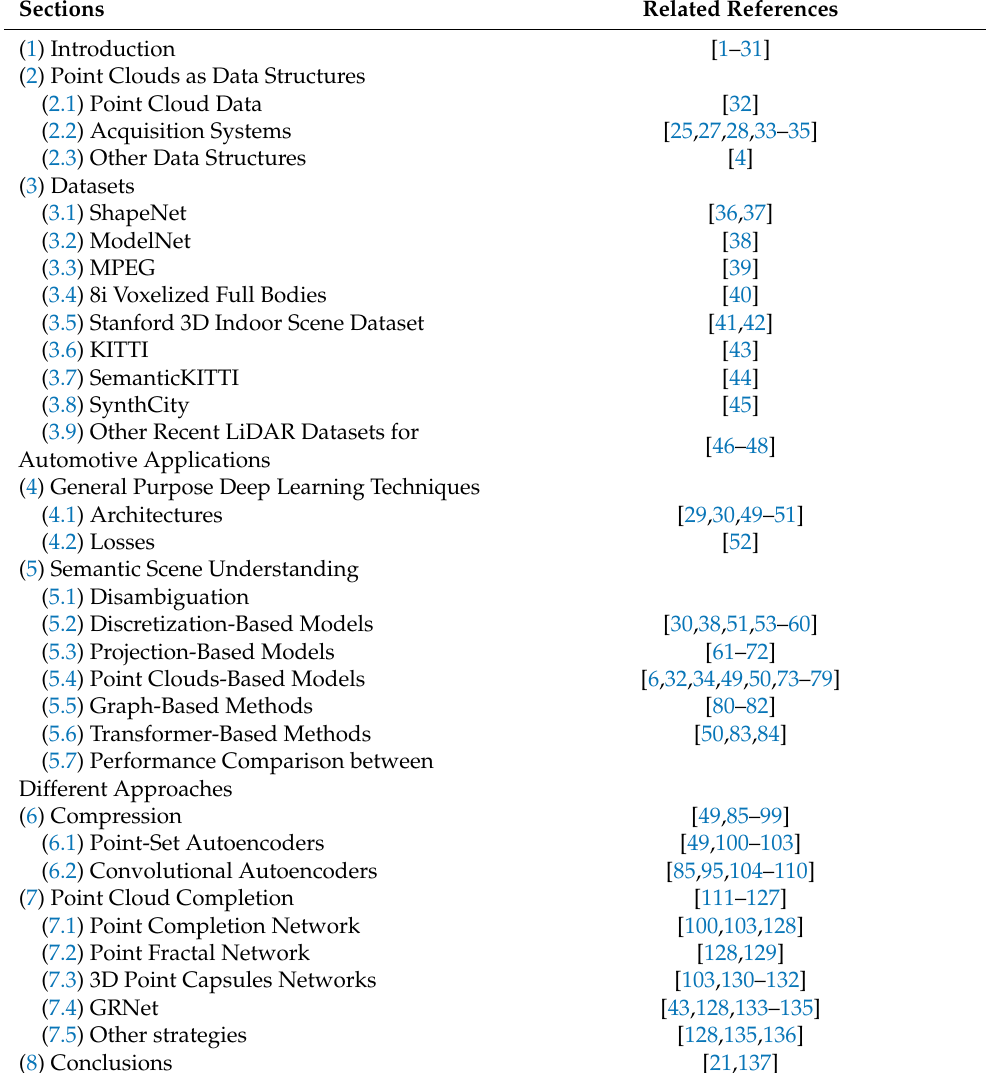
Table 1. Structure of the paper and related